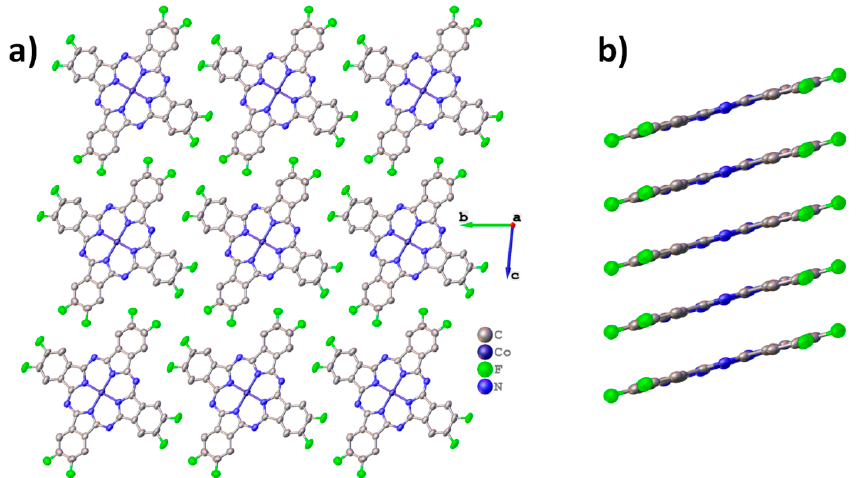
Figure 2. Molecular packing diagrams for CoPcF 8 : molecular stacks along the a axis ( a ), molecular arrangement inside the individual stack ( b ).